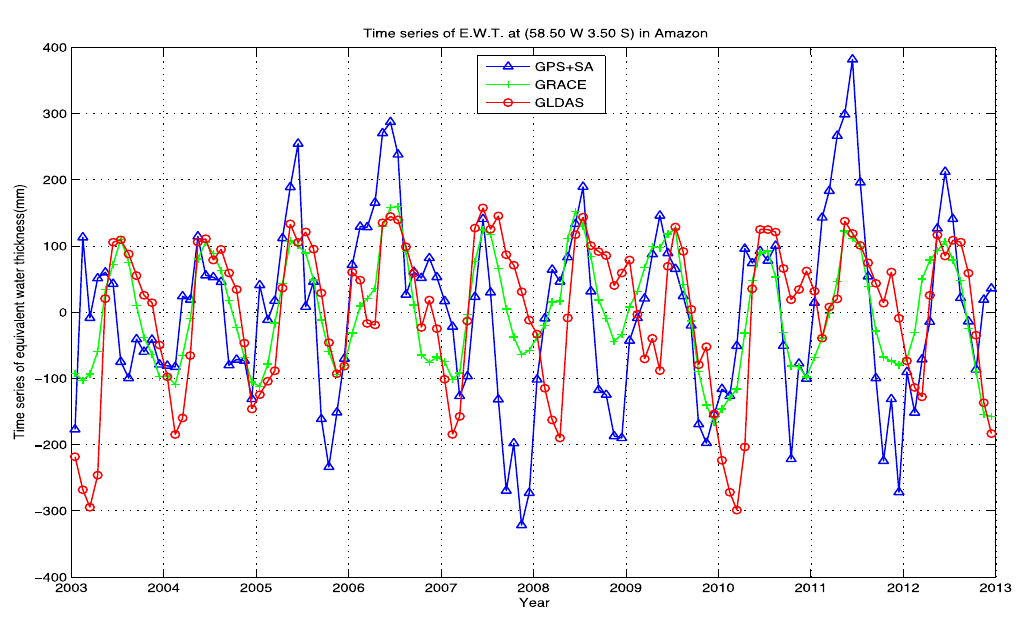
Figure 9. Comparison of time series of terrestrial water storage (TWS) (unit: mm) at point (58.50°W, 3.50°S) in the Amazon between GPS+SA, GRACE and GLDAS.